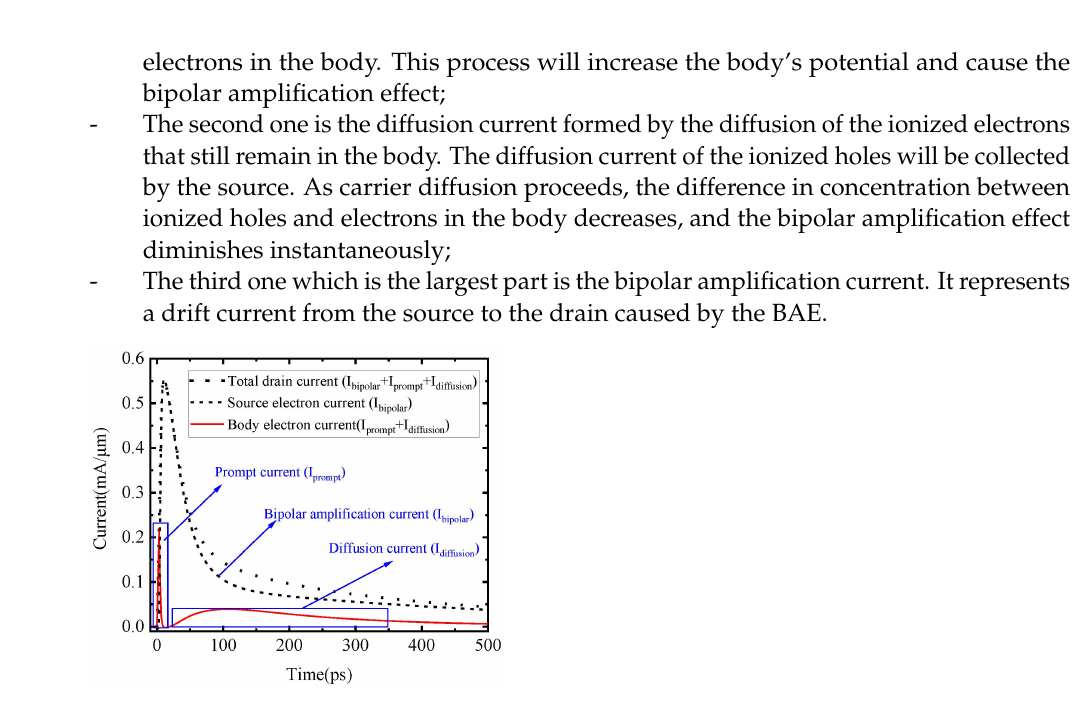
Figure 2. Simulation results of the SET current of the FDSOI device and its three components.